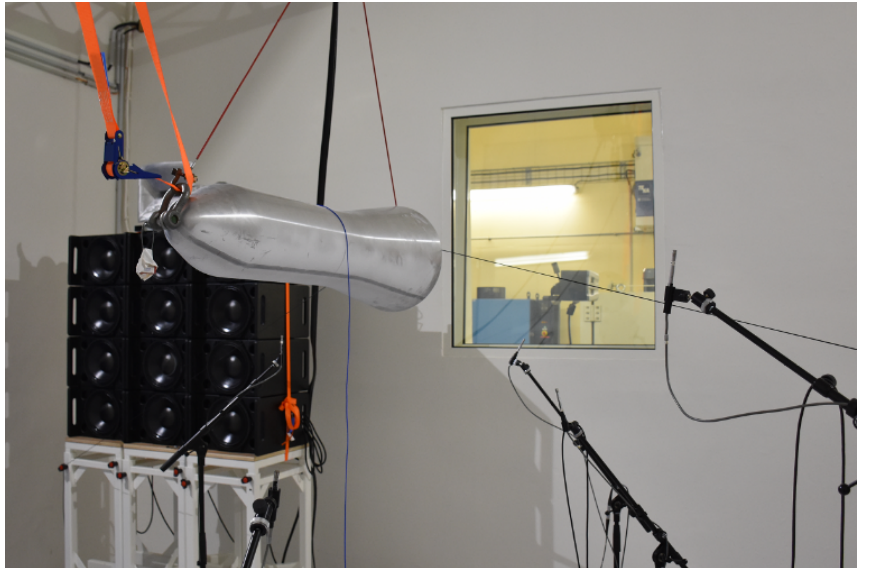
Figure 5. The HB–2 structure in the horizontal configuration in the reverberation chamber and, behind the window, the scanning laser